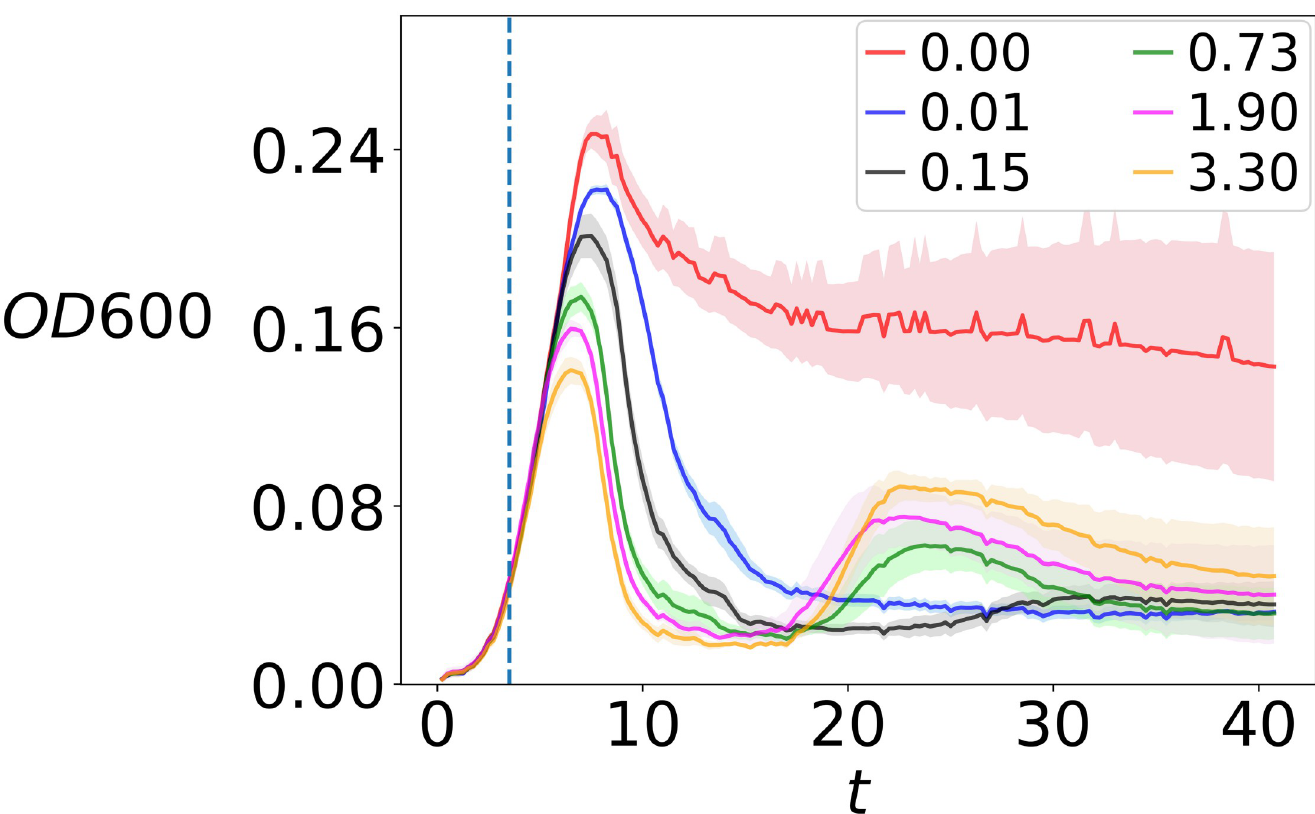
Fig 3. Infection dynamics of B28 virus and E. coli . Infection experiments performed as plate reader assays for different virus to host ratios (VHR). Optical density at 600 nm (OD600) was monitored to serve as a proxy for the host abundance. The growth curve of E. coli without virus infection (control) is shown in red. Plotted curves: mean values ( n = 8 and n control = 11) shown as solid lines and standard deviaitons shown as shading, with the vertical dashed line denoting the time ( t = 3.5 hr) for viral infection.